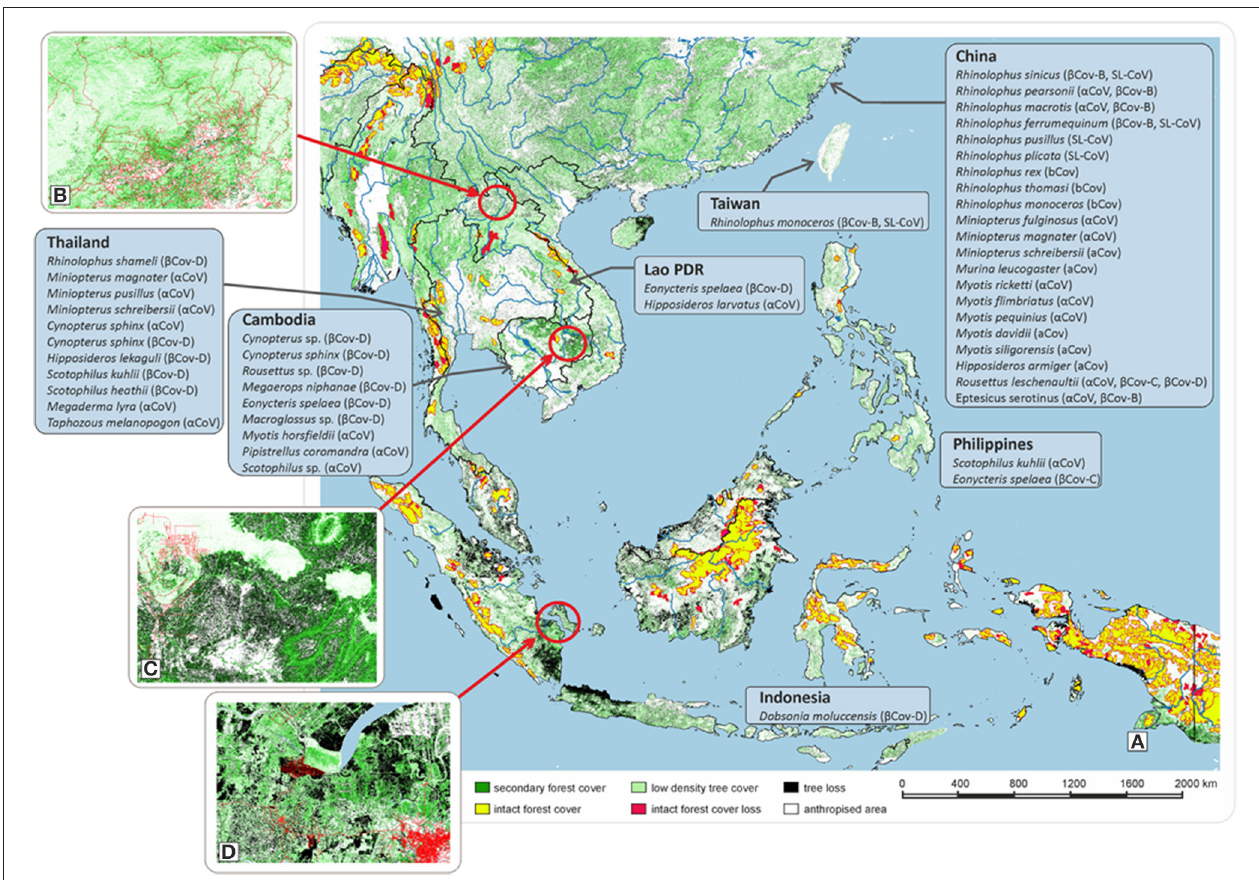
FIGURE 1 | Evolution of the forest cover in Southeast Asia. (A) Changes in forest cover in Southeast Asia from 2000 to 2013. Time-series analysis of Landsat images with a resolution of 30 × 30m. The nature of the vegetation cover (stability or change over a period of 13 years), is indicated by a color code: Yellow: Remaining primary forest (a primary forest is defined as a mosaic of forests and naturally treeless ecosystems within the zone of the current forest extent, which displays no remotely detected signs of human activity or habitat fragmentation and is large enough to maintain all native biological diversity). Red: Lost primary forest, Black: Tree loss, Green: Forest cover, Light green: Low-density tree cover, White: Anthropized area (cultivated land and settlements, including cities). The types of coronaviruses isolated and described in several countries in Asia are presented along with the bat species from which they have been isolated. (B) Example of forest cover loss in Lao PDR with evidence of a low-density tree cover. Land cover evolution from 2000 to 2013. Data obtained using a 30 × 30m resolution (Black: Tree loss; green: Forest cover; light green: Low-density tree cover). (C) Example of forest cover loss in Cambodia where deforestation linked to wood trade and agriculture. Land cover evolution from 2000 to 2013. Data obtained using a 30 × 30m resolution (Black: Tree loss; green: Forest cover; light green: Low-density tree cover). (D) Example of forest cover loss in Sumatra (Indonesia) where deforestation was linked to population growth and agricultural pressure. Land cover evolution from 2000 to 2013. Data obtained using a 30 × 30m resolution (Black: Tree loss; green: Forest cover; light green: Low-density tree cover).